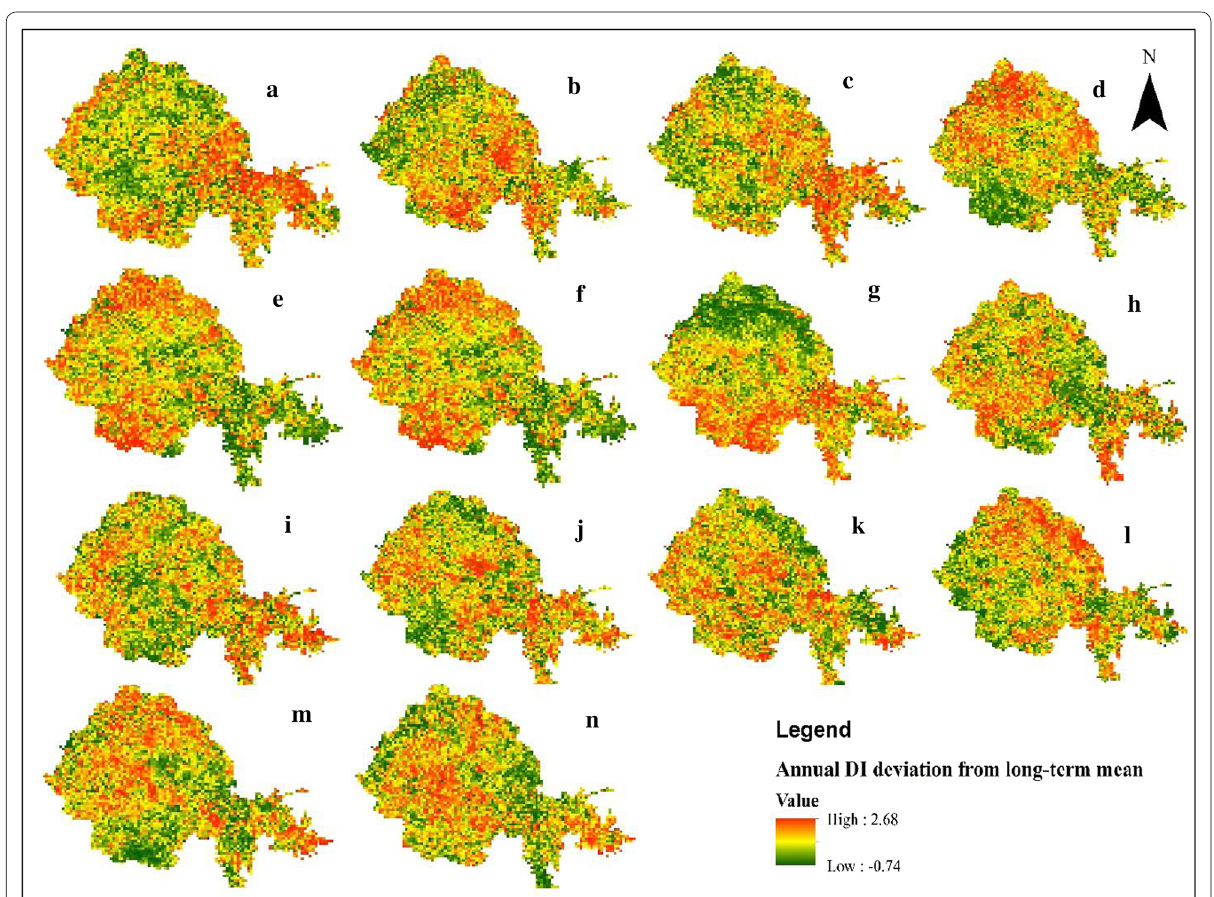
Fig. 8 Spatial patterns of vegetation disturbance in Guna-Tana watershed ( a – n represent vegetation disturbance index anomaly from long-term mean disturbance from 2003 to